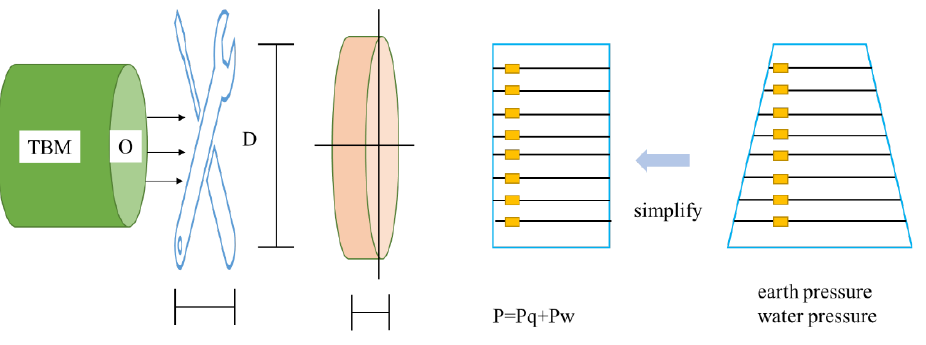
Figure 1. Simplified mechanical model.